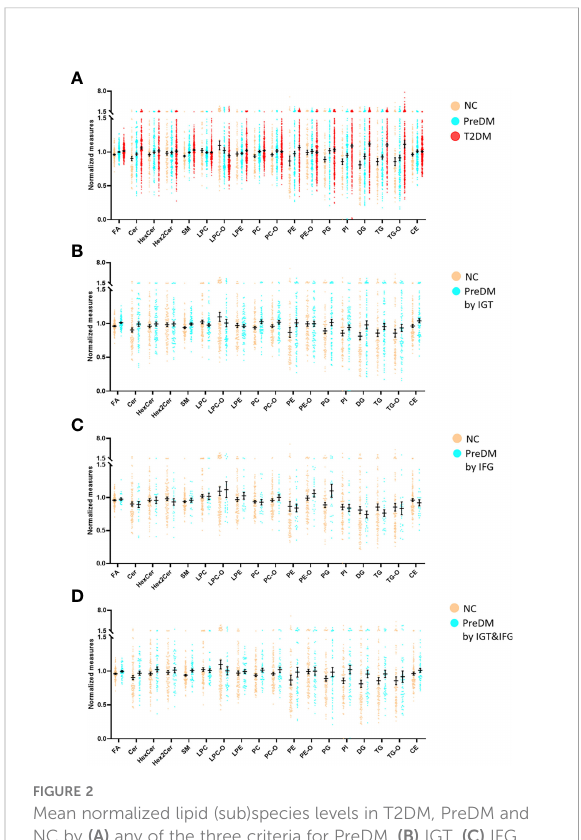
FIGURE 2 Mean normalized lipid (sub)species levels in T2DM, PreDM and NC by (A) any of the three criteria for PreDM, (B) IGT, (C) IFG and (D) IGT&IFG in the discovery set. Data are expressed as means ±